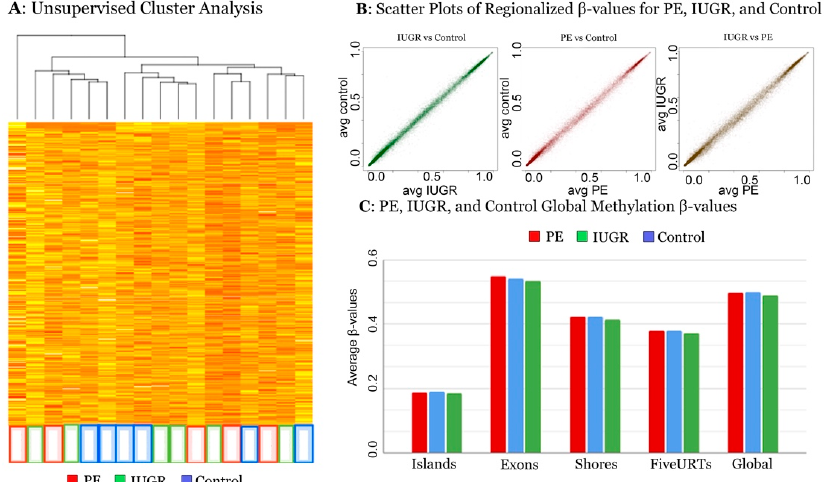
Figure 1. Comparative analyses of global profiles for PE, IUGR, and control placental tissues. Unsupervised cluster analysis of regionalized β -values for samples with a dendrogram indicating similarity ( A ). Scatter plots of regionalized β -values for IUGR vs Control, PE vs Control, and IUGR vs PE, respectively ( B ). Bar plots of average β -values at five global regions of interest ( C ).